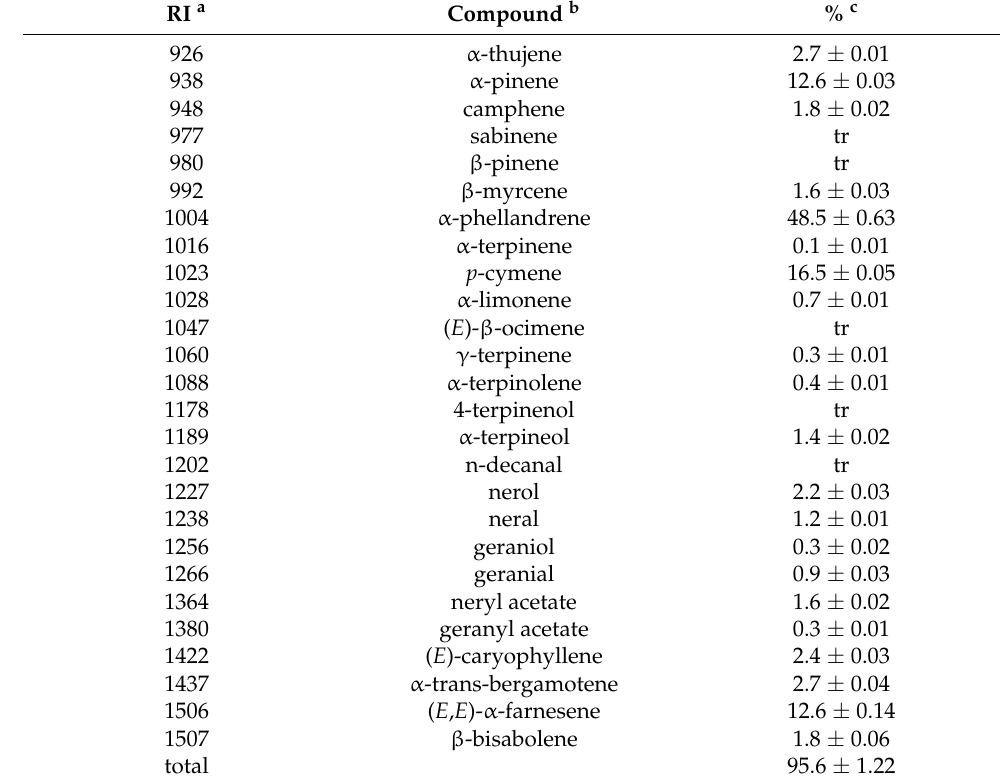
Table 1. Chemical composition of CAEO.